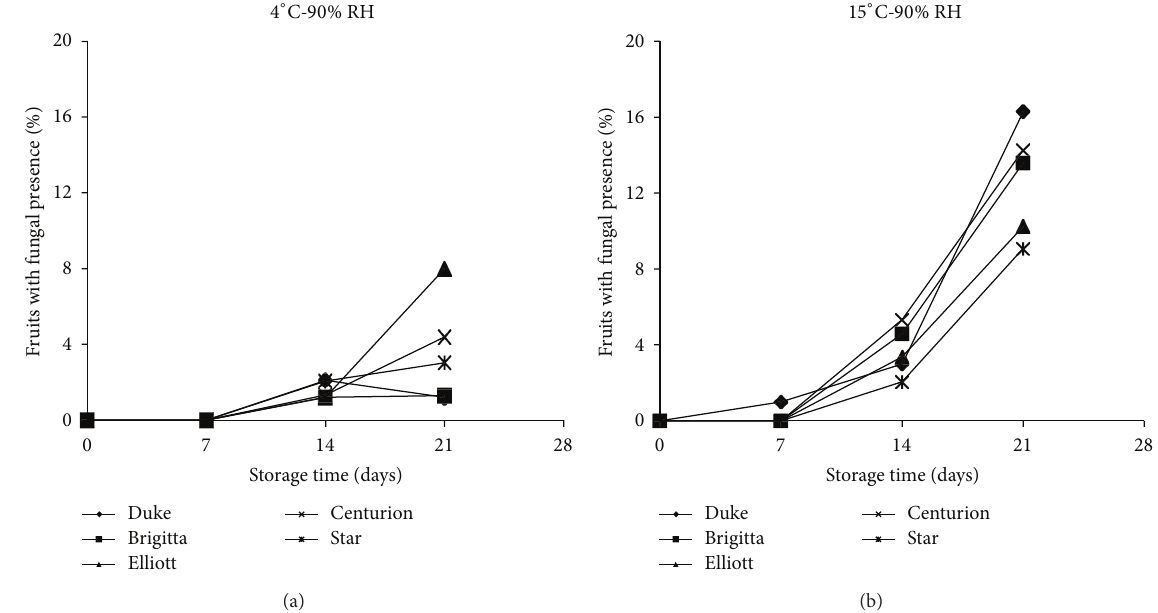
Figure 6: Percentage of fruits with fungal presence (6) in six blueberry cultivars stored under different storage conditions (4 and 15 ∘ C and 90% RH).